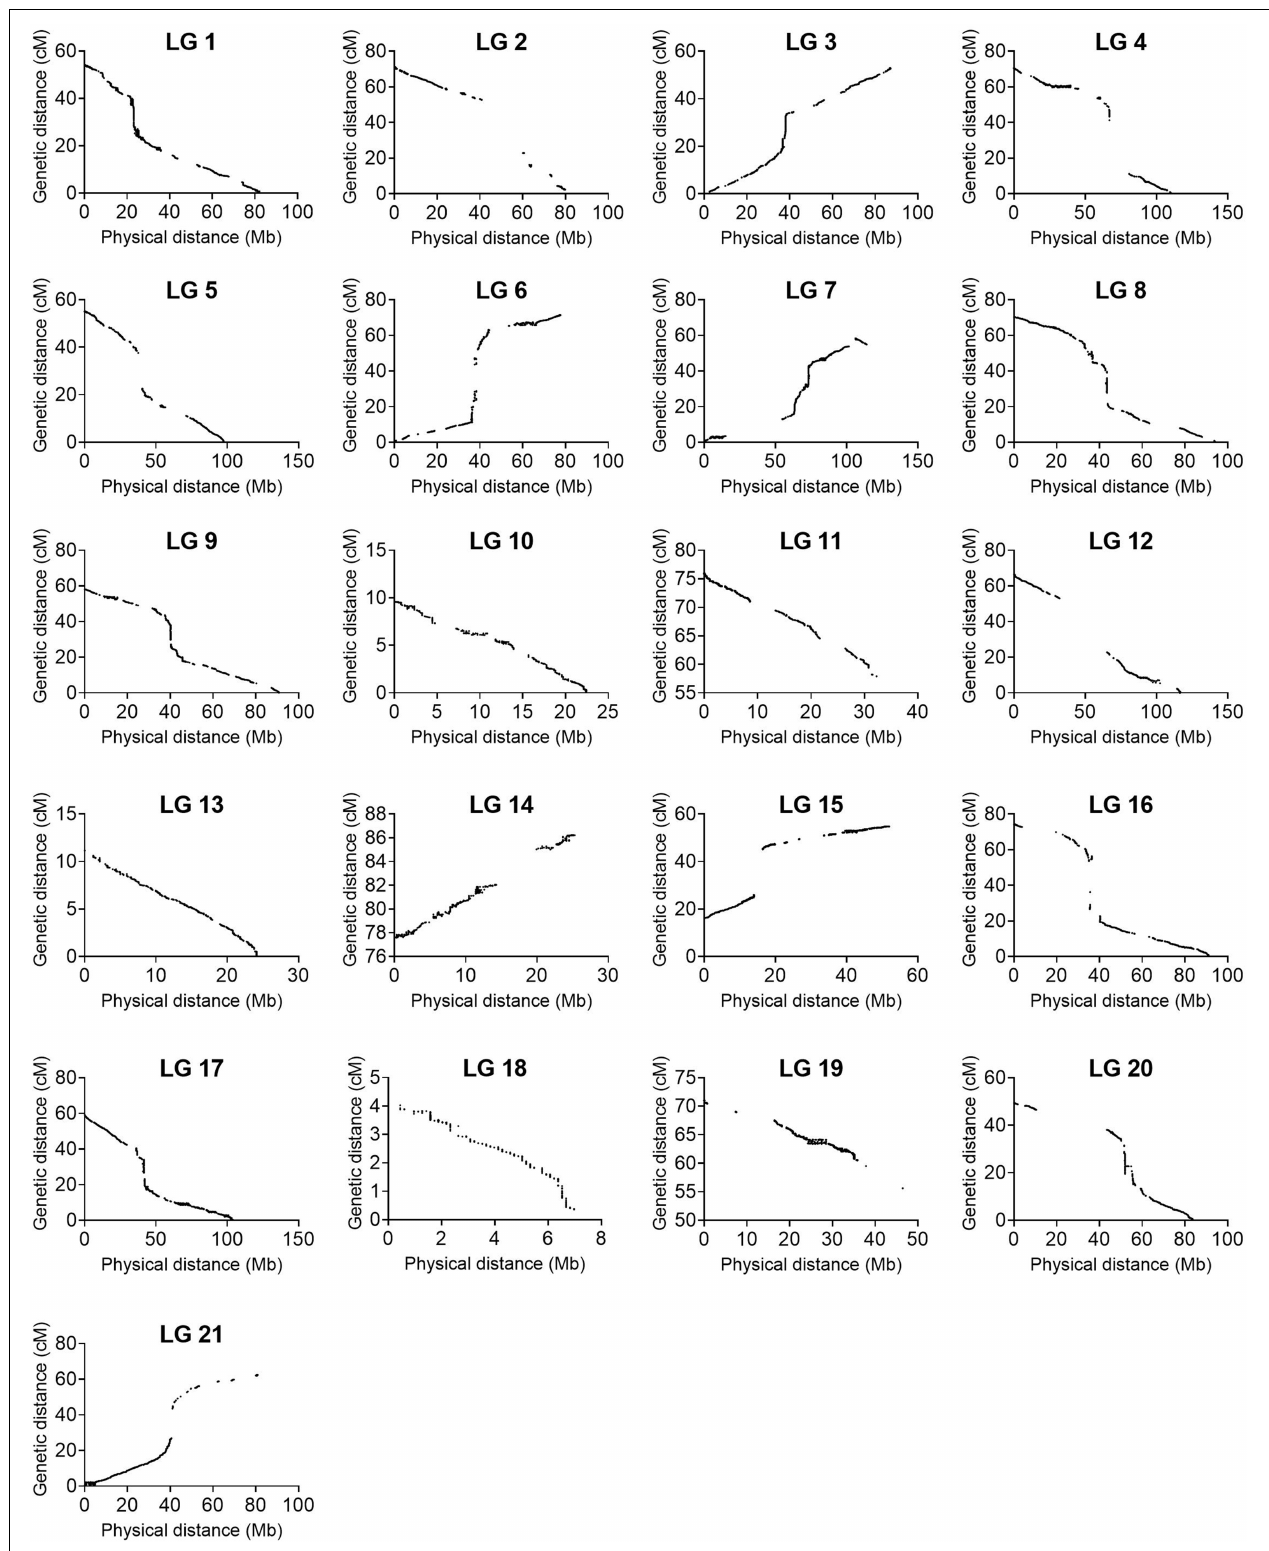
FIGURE 3 | Collinearity between the linkage map constructed in this study and the physical map from the reference genome QQ74_V2 (CoGe Genome ID: id60716). The graphs were constructed with 133,913 non-binned markers.